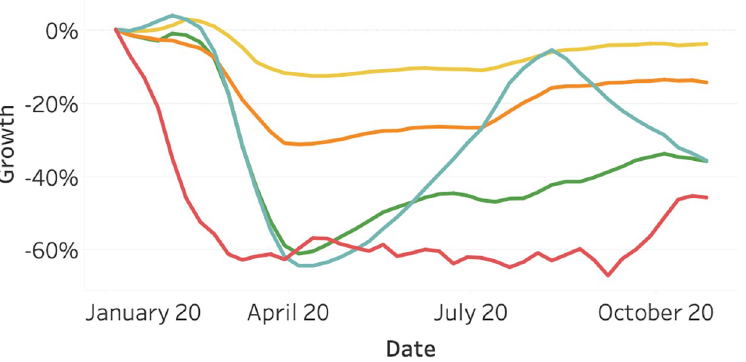
Fig 4. Online searches for train through Google as of January 2020, split per continent. North America (orange), South America (yellow), Asia (red), Europe (light blue), and Oceania.